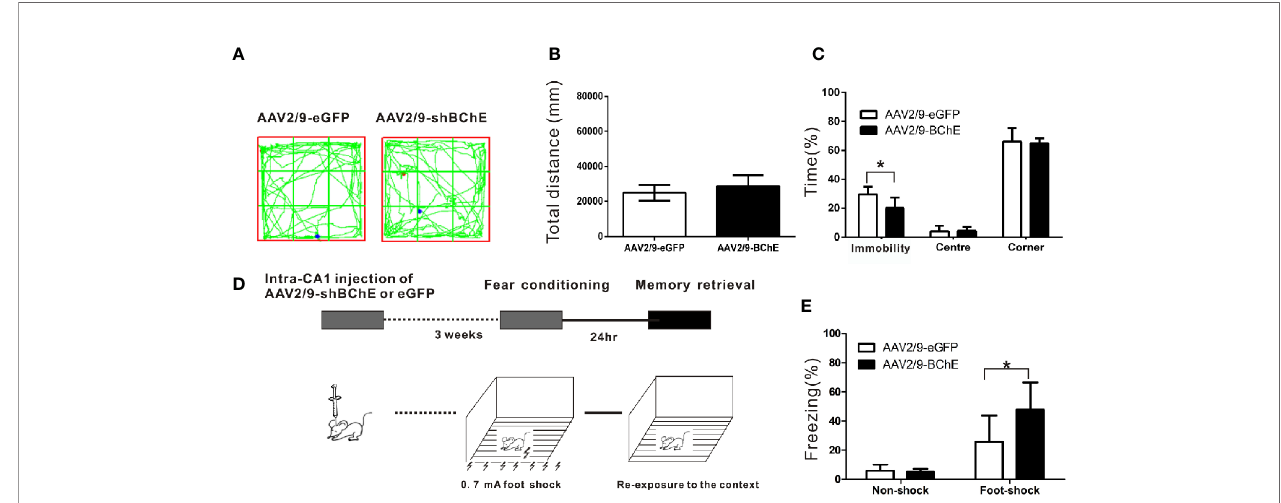
FIGURE 3 | BChE knockdown in the hippocampal CA1 region strengthened contextual fear memory expression. (A) The locomotor trajectories of the AAV2/9- shBChE and control AAV2/9-eGFP groups in the open fi eld. Representative exploratory traces are shown. (B) The total distance traveled in the open- fi eld was similar between the AAV2/9-shBChE and control AAV2/9-eGFP groups when mice were tested for 24 h ( p = 0.063; n = 6 – 7 mice per group). (C) The results showed a difference in immobility time between the two groups ( p = 0.020, * p < 0.05; n = 6 – 7 mice per group). No signi fi cant difference in time spent in the center or time spent in the corner was observed between the AAV2/9-shBChE and control AAV2/9-eGFP groups (time spent in the center: p = 0.852; time spent in the corner: p = 0.769; n = 6 – 7 per groups). The data are presented as the mean ± SD. (D) Schematic of the procedure used in this experiment. (E) Percentage freezing increased due to BChE knockdown ( p = 0.005, * p < 0.05; n = 13 – 14 mice per group). The results showed no signi fi cant difference between the two no shock groups ( p = 0.704; n = 7 per group). The data are presented as the mean ±